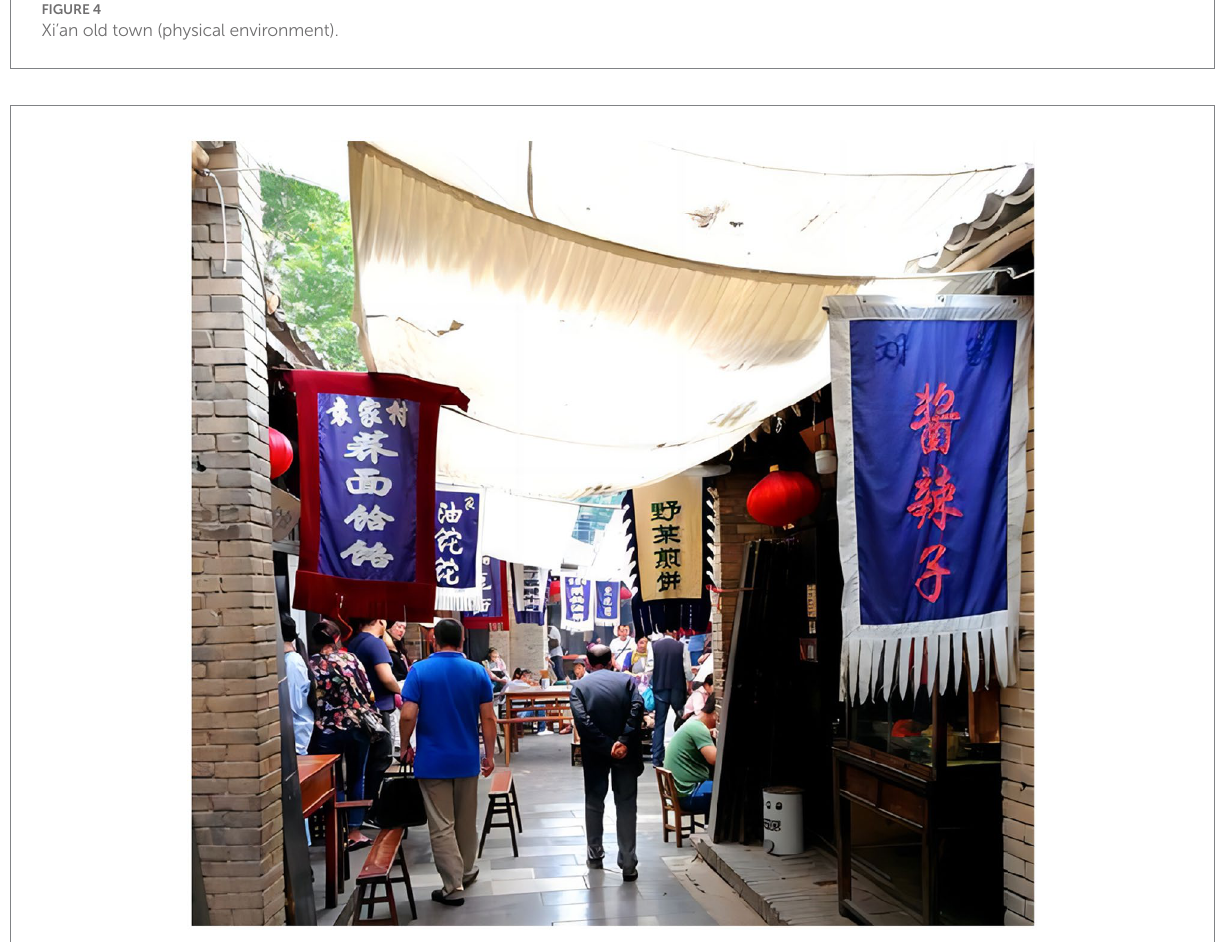
FIGURE 5 Yuanjia village (social